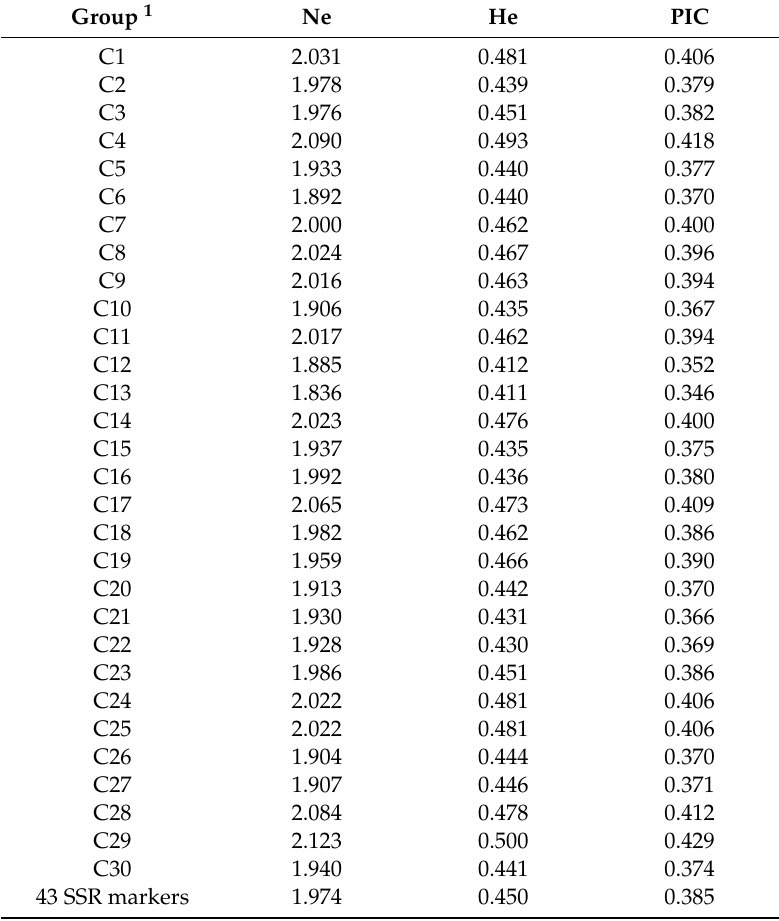
Table 3. Genetic diversity of 30 combinations of 22 SSR markers. Group 1